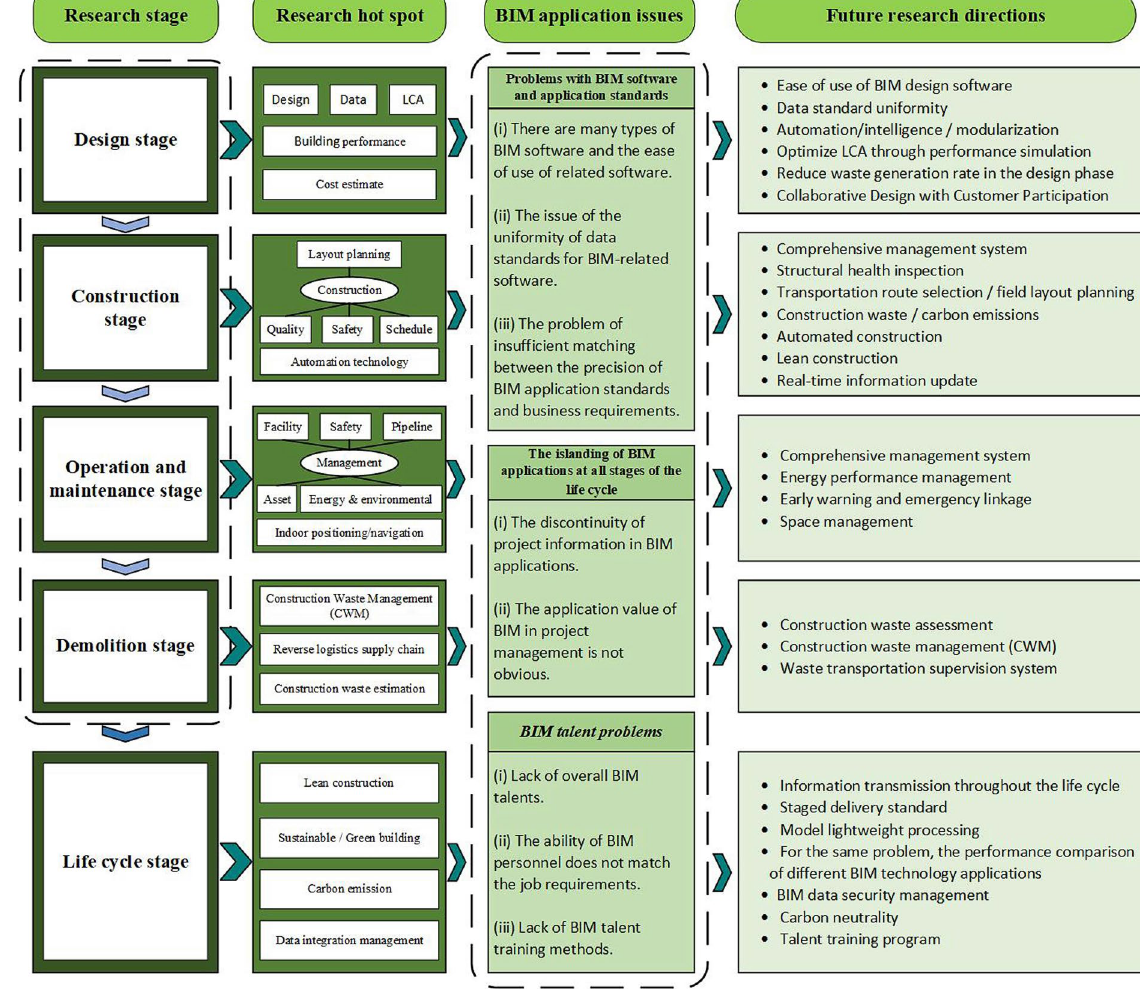
Figure 10. Research status and future development direction of